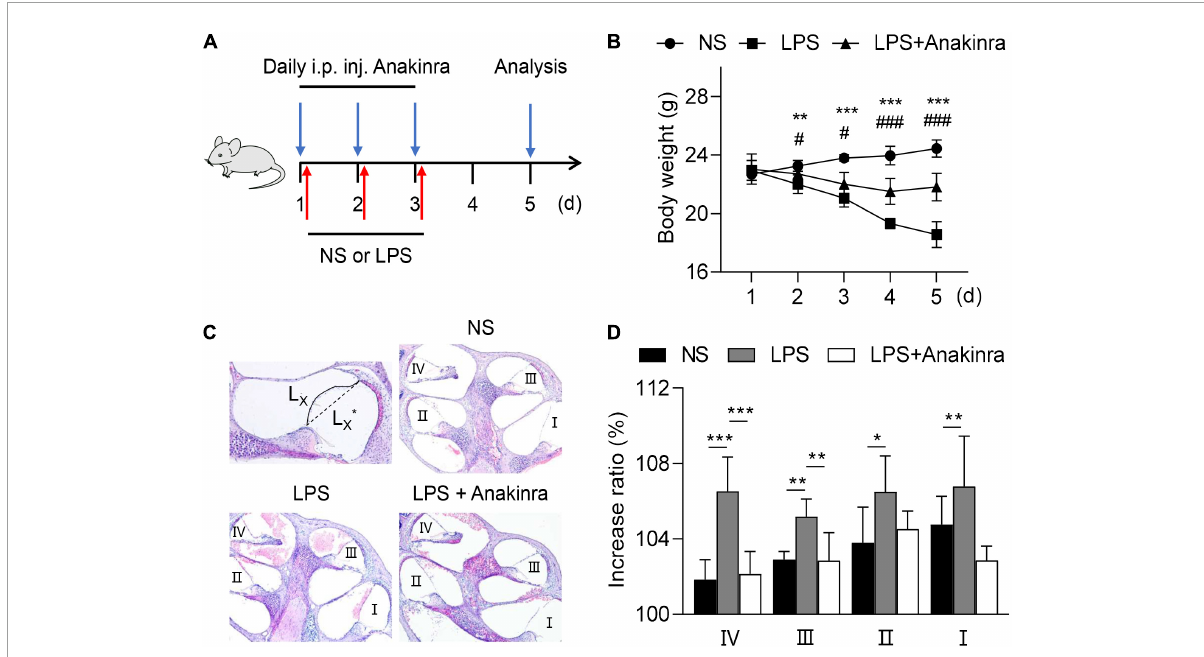
FIGURE1 Anakinra reduced the severity of LPS-induced endolymphatic hydrops in mice. (A) Mice were untreated or pretreated treated with Anakinra (10 mg/kg) and challenged with LPS (10 mg/kg, i.p.) or equivalent saline for 3 consecutive days, then sacrificed at 5 days. (B) Changes of body weight in all groups ( n = 5, *NS group compared to LPS group, # LPS group compared to LPS + AN group). (C) Representative images of mid-modiolar cochlear sections in all groups. (D) Measurements of the increase rations of the length of the Reissner’s membrane in cochlear half-turns I–IV ( n = 5). Data are presented as mean ± SD. *or # p < 0.05, ** < 0.01 ***or ### p < 0.001. NS, 0.9% normal saline; i.p. inj., intraperitoneal